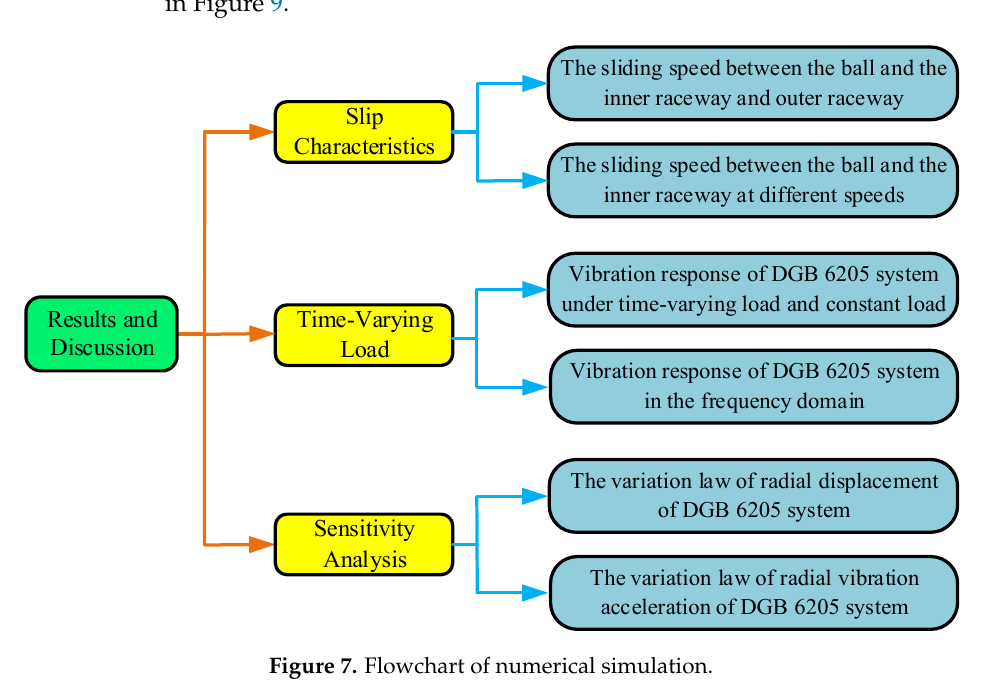
Figure 7. Flowchart of numerical simulation.